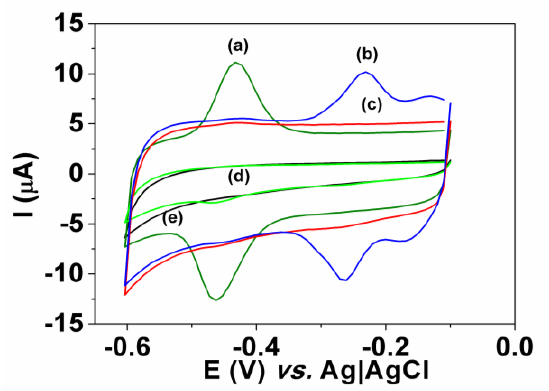
Figure 6. Cyclic voltammograms obtained for the reduction of 1.0 × 10 −5 mol·L −1 AG25 dye ( b ), AB1 ( c ), AR33 ( d ), BB99 ( e ) and blank ( a ) in 0.04 mol·L −1 B-R buffer pH = 4.0. Scan rate: 60 mV·s −1